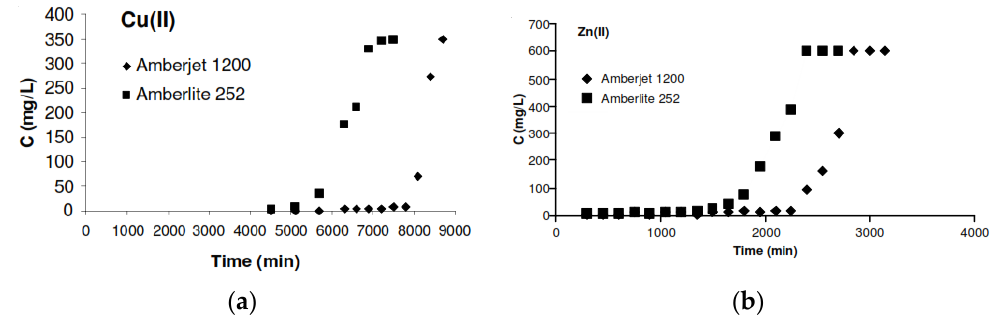
Figure 18. Comparison between the performance of Amberjet 1200 and Amberlite 252 for removal of ( a ) copper (II) and ( b ) zinc (II) [187]. ( a ) copper (II) and ( b ) zinc (II)